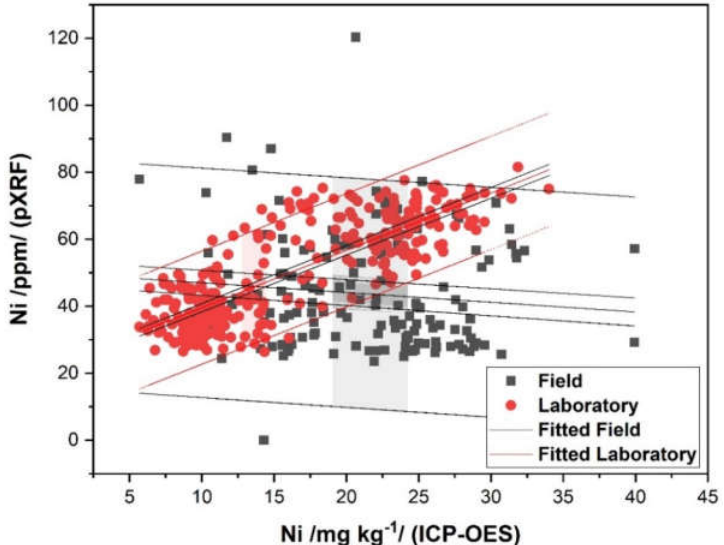
Figure 4. Statistical significance of regression model for Nickel (pXRF) in soil samples from experimental soil sites from Otava and Mže river basins measured in FIELD and LABORATORY.